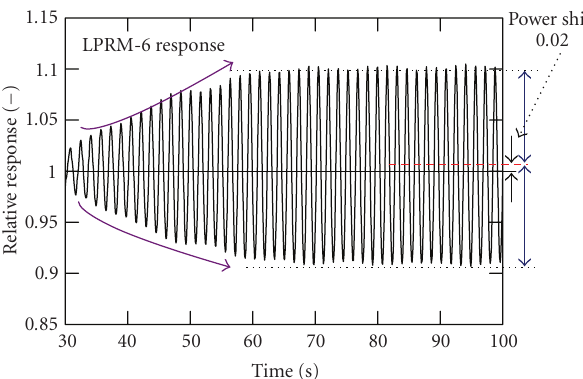
Figure 10: Average power shift in simulated Ringhals-1 C14/PT9 regional